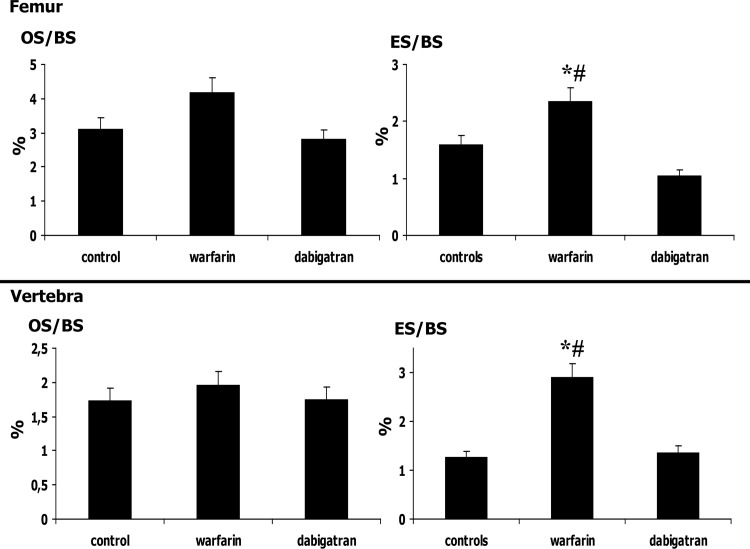
Significant histomorphometric results of cellular parameters in femur (upper panel) and vertebra (lower panel) analysis of rats.The main alteration of cellular parameters in warfarin treated rats was the increased osteoclast activity (ES/BS), although in femur a decreased osteoblast activity (OS/BS) was also detected. ES/BS: Erosion Surface / Bone Surface; OS/BS: Osteoid Surface / Bone Surface. *p< 0.01 vs control; #p<0.001 vs dabigatran; ##p< 0.005 vs dabigatran.